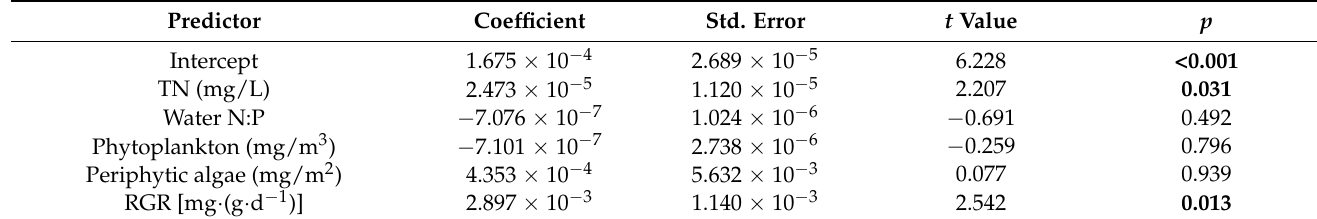
Bold numbers indicate significant differences ( p < 0.05).